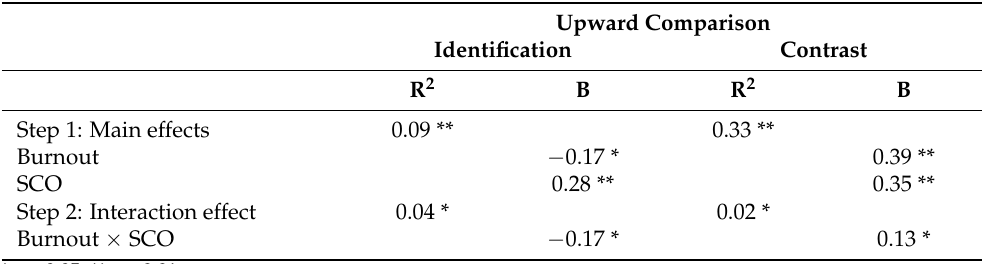
Table 1. Results of hierarchical regression of positive and negative affect as a response to upward comparison in Study 1 [13].